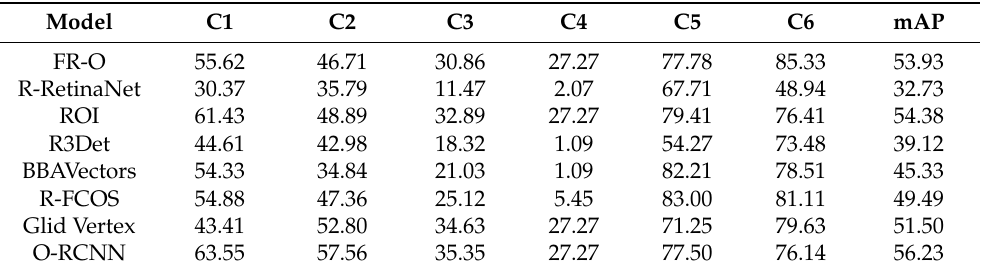
Table 6. Ship detection results of the mAP and AP of each category for several models.